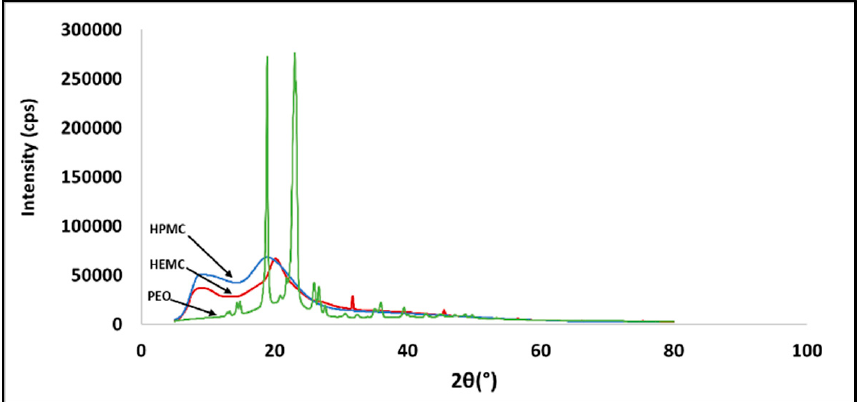
Figure 1. X-ray diffraction pattern of HEMC, HPMC, and PEO.